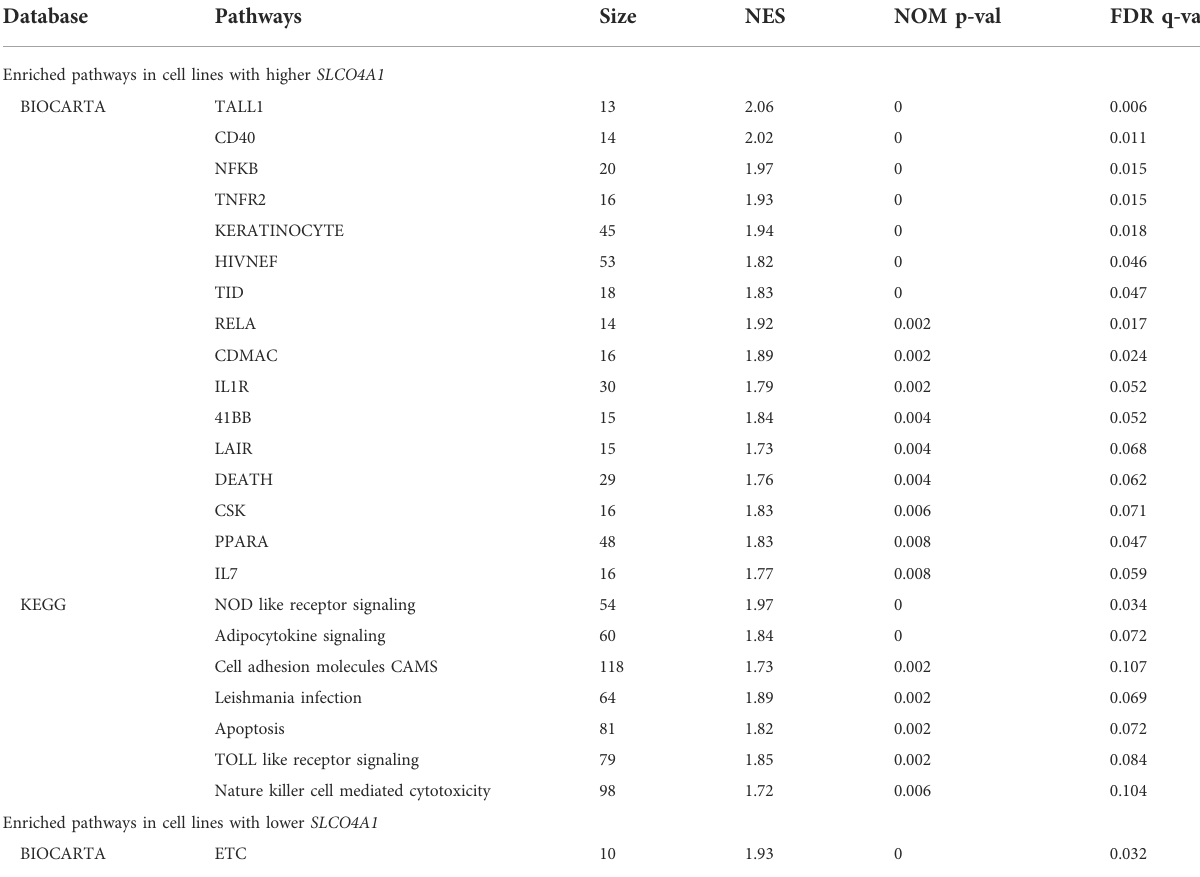
TABLE 1 Over-presented pathways in relation with SLCO4A1